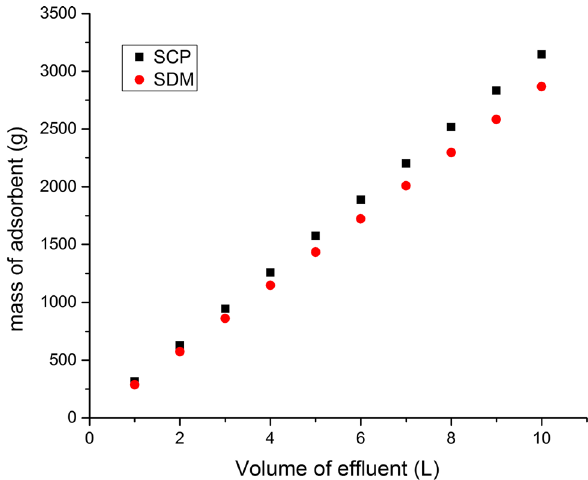
Fig. 11 Variation of the theoretical mass of Fe-MC with volume required for SCP and SDM effluents to be treated for 99% removal efficiency with initial concentration of 0.2 mg L −1 at 303